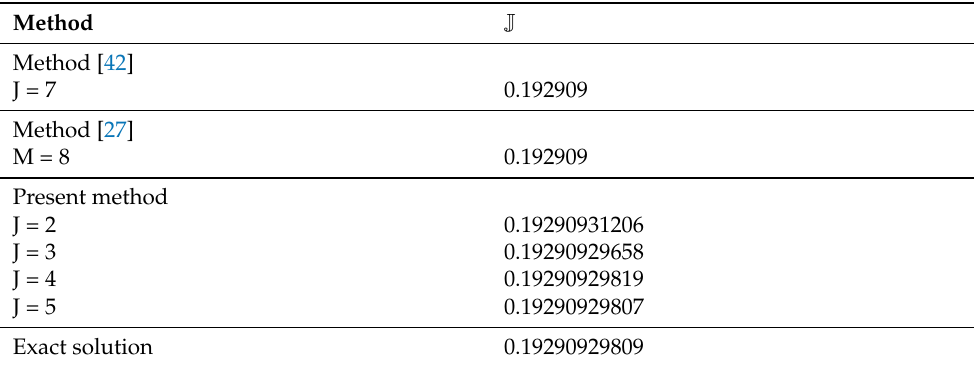
Table 2. Estimated values of J for Example